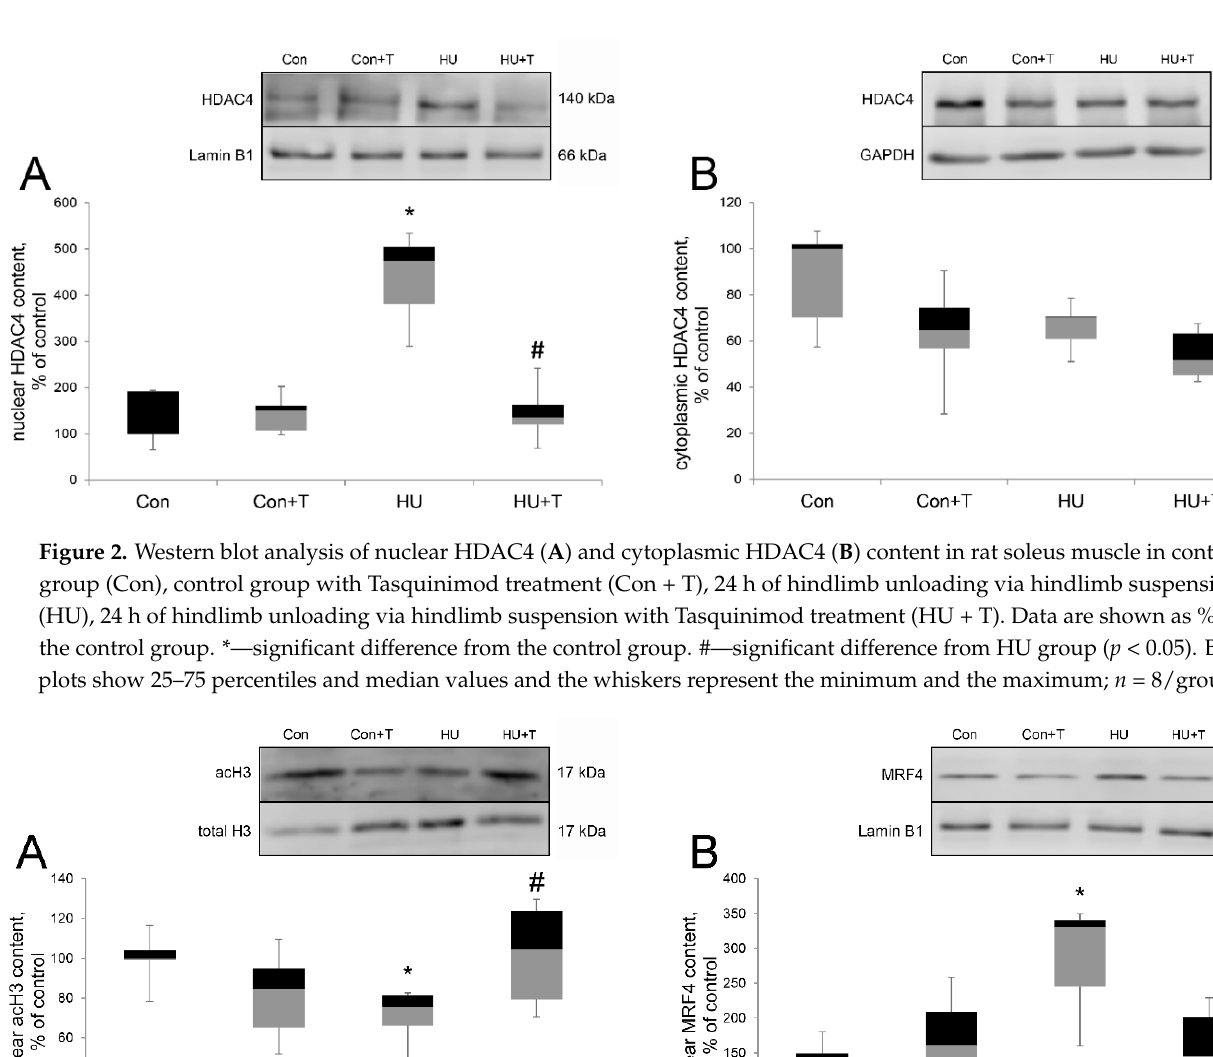
Figure 3. Western blot analysis of acH3 ( A ) and MRF4 ( B ) nuclear content in rat soleus muscle in control group (Con),